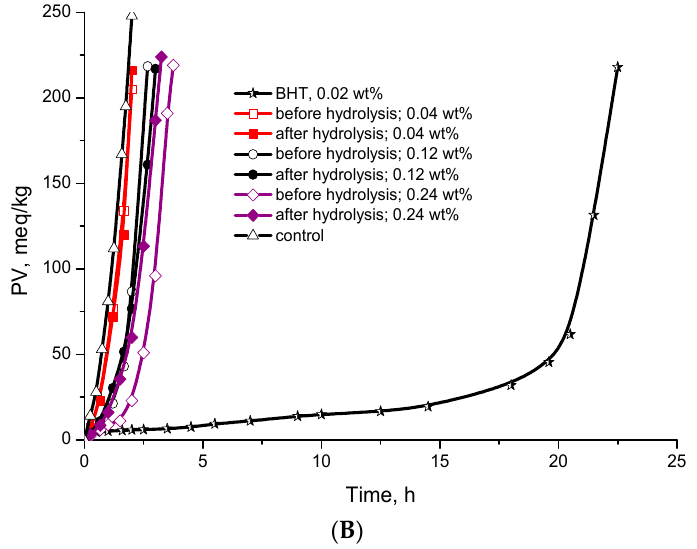
Figure 4. Kinetic curves of lipid hydroperoxides (LOOH) accumulation during oxidation of triacylglycerols of sunflower oil (TGSO) autoxidation at 80 °C in presence of flaxseed extracts before hydrolysis and ferulic acid (FA) ( A ) and in presence of flaxseed after hydrolysis and butylated hydroxyl toluene (BHT) ( B ).